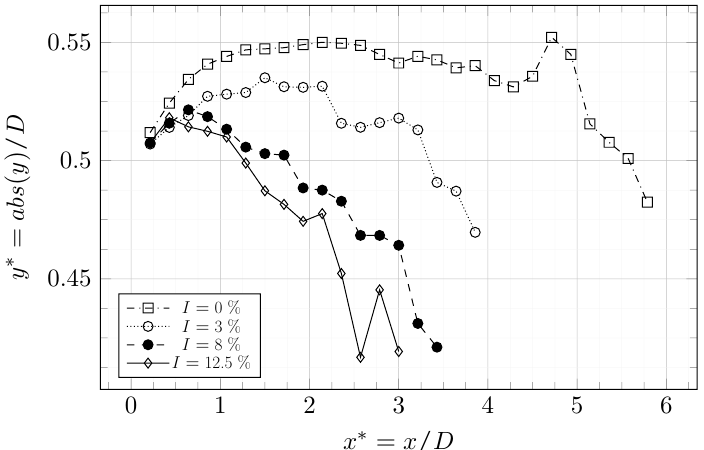
Figure 28. LBM-LES simulation of the tidal turbine at TSR = 3.67. Average height of tip-vortices intersections for I = [ 0,3,8,12.5 ]